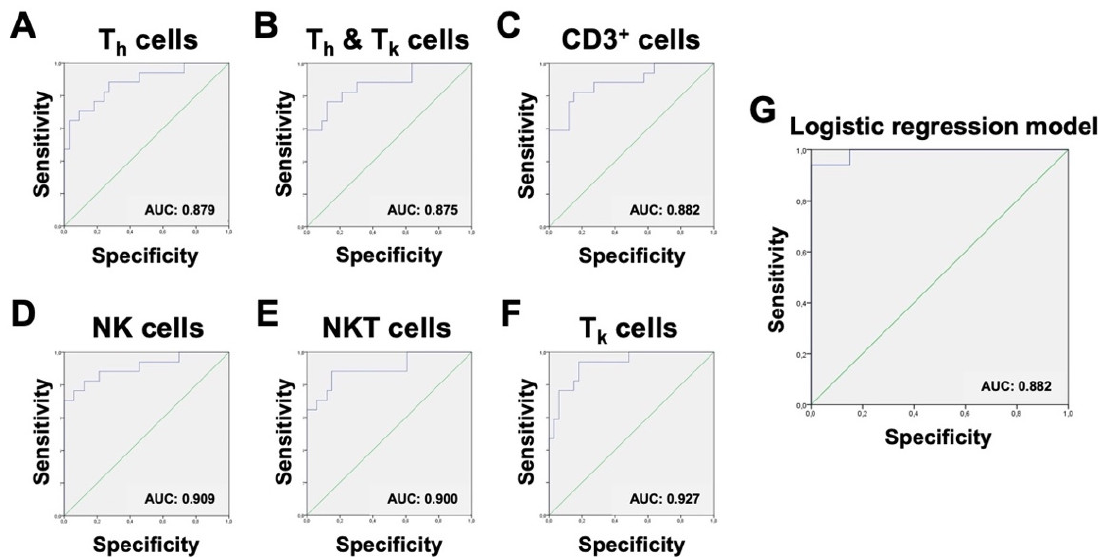
Figure 8. Results of ROC analysis of the most significant non-granulocytic ratios. Ranking from ( A – F ) shows the graphs in ascending order of their respective Youden-index. Areas under the curve (AUCs) are displayed at the bottom right of the diagram. Graph ( G ) shows the ROC curve of the logistic regression model, representing an algorithm combining the abundance of NK cells, CD3 + cells, monocytes, and neutrophil granulocytes.